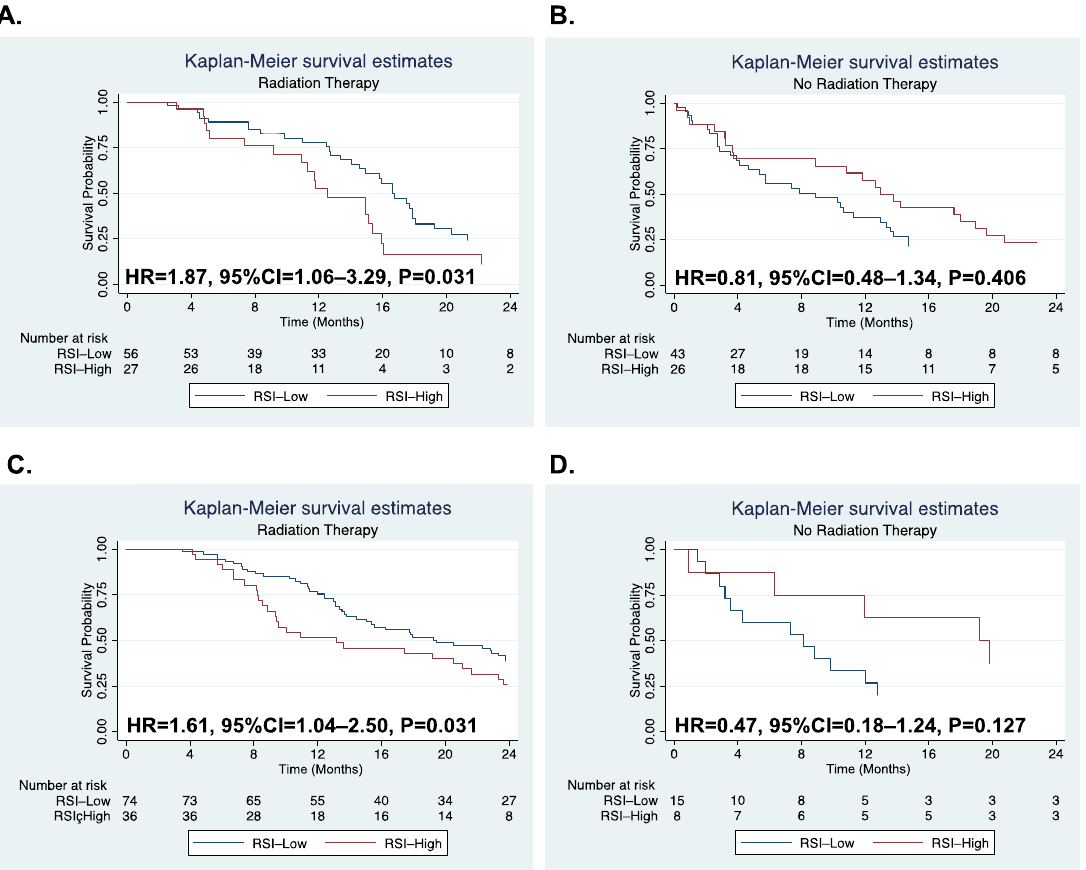
Figure 1. In TCGA glioblastoma population, Kaplan–Meier curves are compared between RSI-high and RSI-low groups for patients who received radiation therapy ( A ) and did not receive it ( B ). In CCGA glioblastoma population, Kaplan–Meier curves are compared between RSI-high and RSI-low groups for patients who received radiation therapy ( C ) and did not receive it ( D ). p -value was estimated by Cox proportional hazard model. Abbreviations: HR, hazard ratio; CI, confidence interval; RSI, radiosensitive index; TCGA, The Cancer Genome Atlas, CGGA, The Chinese Glioma Genome